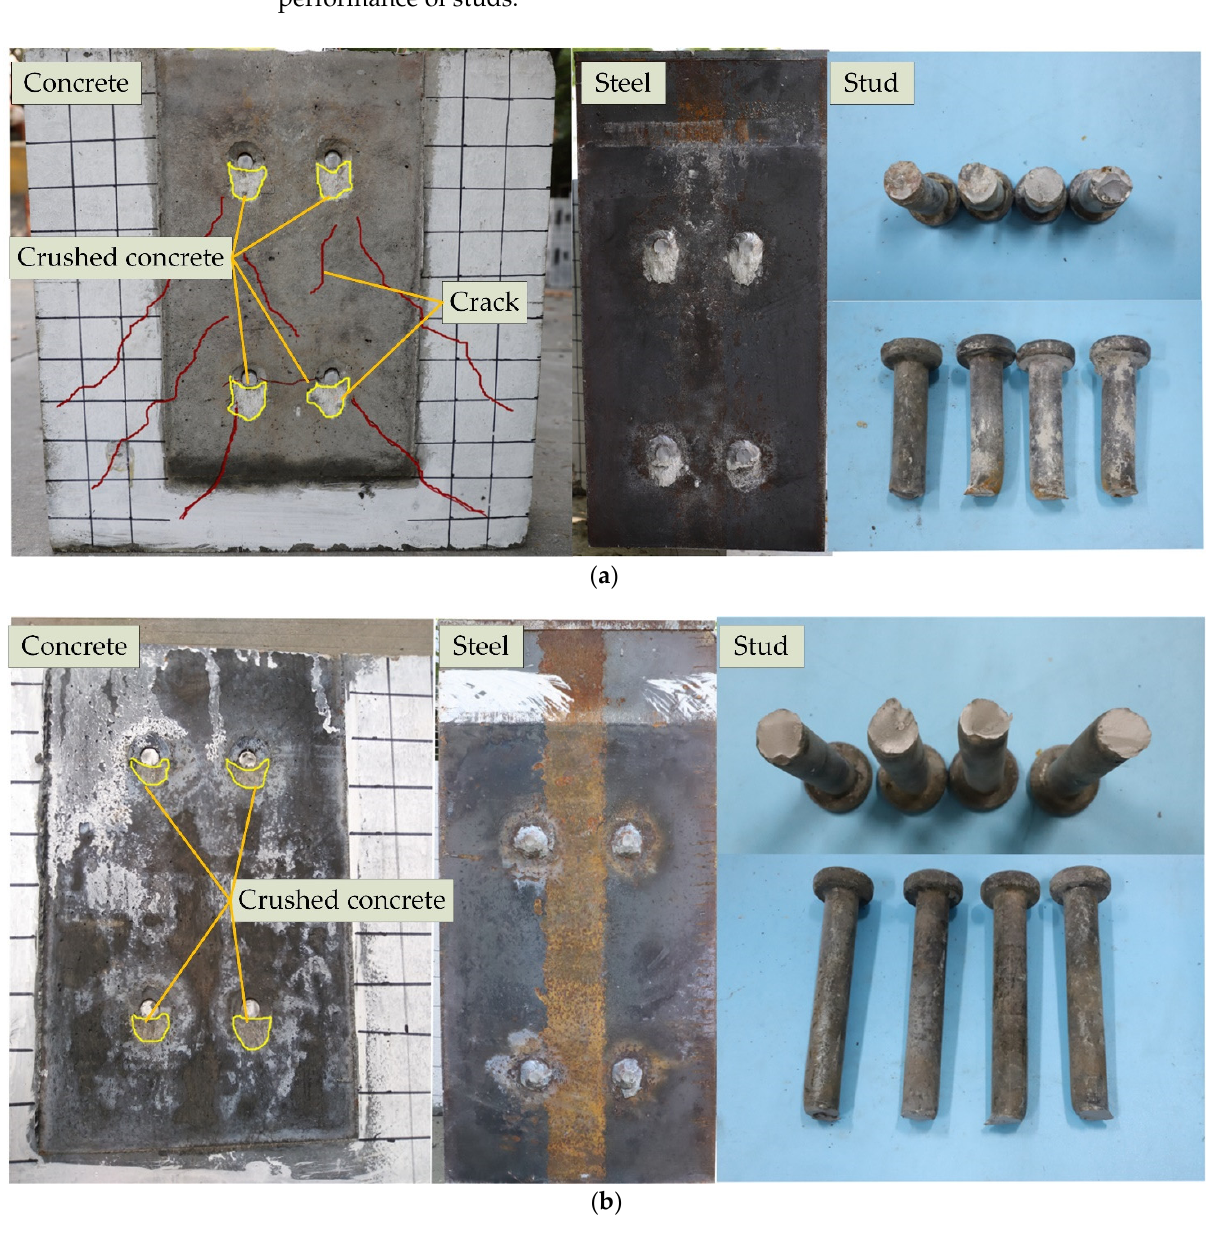
( b ) Figure 6. Load-slip curves of different stud lengths: ( a ) 80 mm; ( b ) 120 mm. As can be seen from Figure 6, the shear bearing resistance of studs embedded in the steel-concrete composite beams was significantly affected by the concrete compressive strength and the stud diameter. In the steel-NC specimens, the average shear bearing ca- pacities of the studs with 14 mm, 18 mm, and 22 mm diameters were 822.54 kN, 1168.06 kN, and 1272.66 kN, respectively, and in the steel-SFRCC specimens, the corresponding